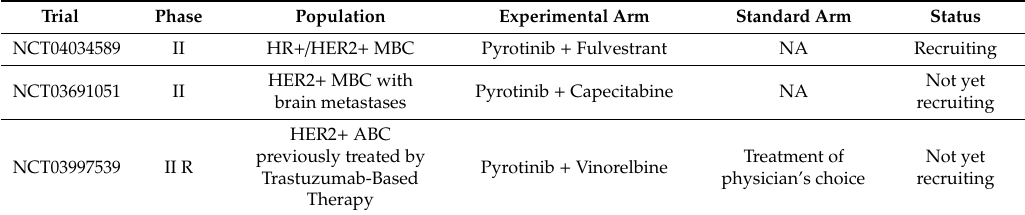
Table 3. Ongoing trials evaluating pyrotinib in HER2-positive